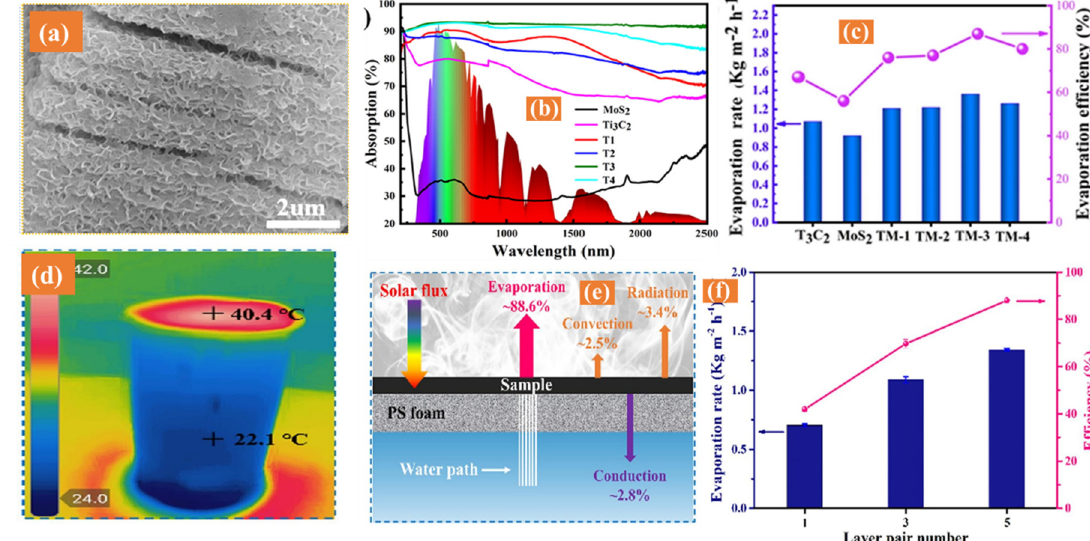
Figure 7. ( a ) Surface morphology of Ti 3 C 2 /MoS 2 composite at evenly distributed MoS 2 layers on accordion-like Ti 3 C 2 , ( b ) solar absorption behavior of pure Ti 3 C 2 , MoS 2 , and various mass fractions of MoS 2 in Ti 3 C 2 /MoS 2 , and ( c ) corresponding water evaporation rate and solar evaporation efficiency (reprinted from Ref. [64], copyright with permission from Elsevier, 2021), ( d ) variation in the temperature change on the surface and bottom of five times layer-by-layer grown Ti 3 C 2 T x MXene/CNT composite, ( e ) evaporation, convection, radiation, and thermal conduction rate during solar desalination, and ( f ) corresponding evaporation rate and light conversion efficiency of Ti 3 C 2 T x MXene/CNT at different layer growths (1, 3, and 5) (reprinted from Ref. [65], copyright with permission from Elsevier, 2021).